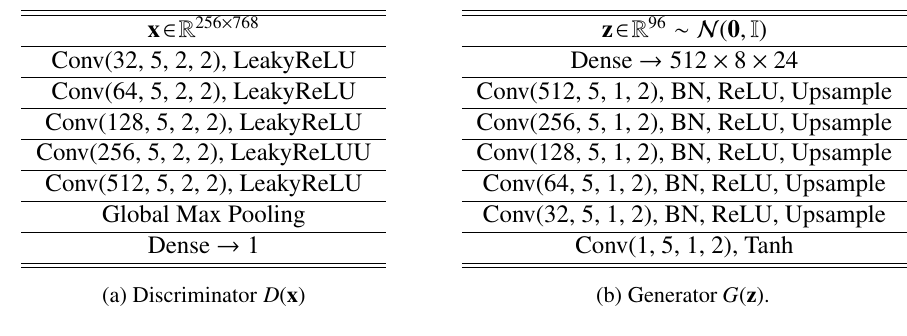
Table 1: Architecture of the discriminator and generator models of the GAN for the gener- ation of PXD beam background data. Conv denotes convolutional layers and the values in parenthesis specify the numbers features and the sizes of kernel, stride, and padding. BN refers to BatchNorm